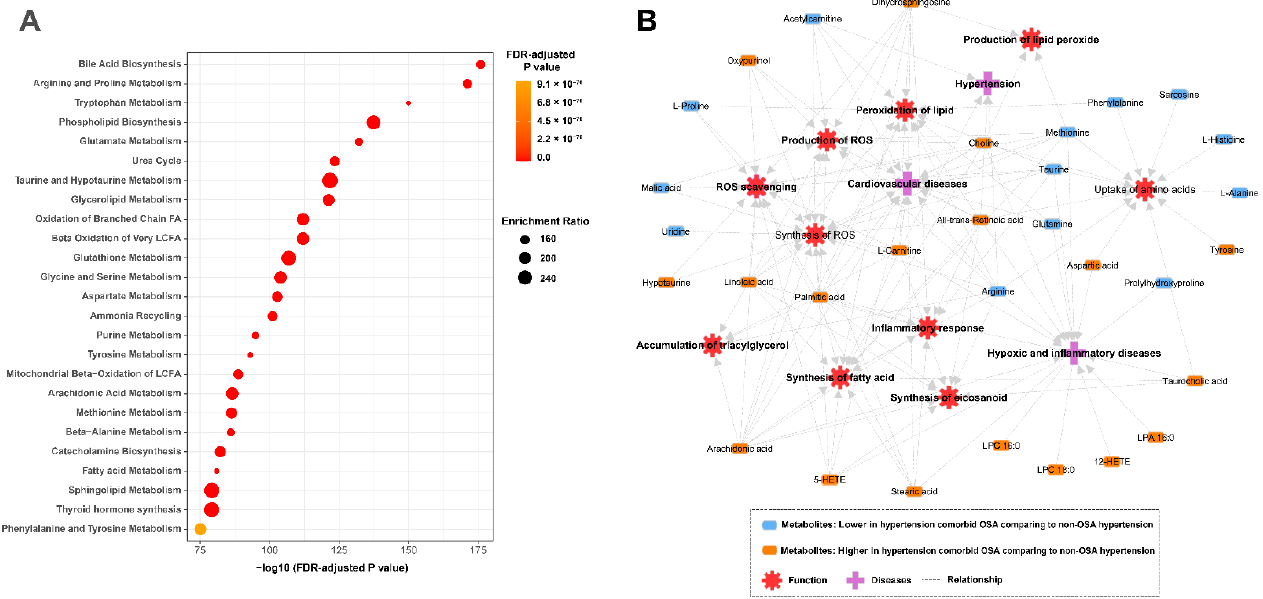
Figure 4. Pathway and function analyses of differentiated metabolites. ( A ) Metabolic pathway enrichment analysis by using MetaboAnalyst. The bubble size refers to the enrichment factor of the pathway and the color represents the FDR-adjusted p value of pathway significance. ( B ) Functional network between the metabolic signatures and biological pathways/diseases by using Ingenuity Pathway Analysis Database.